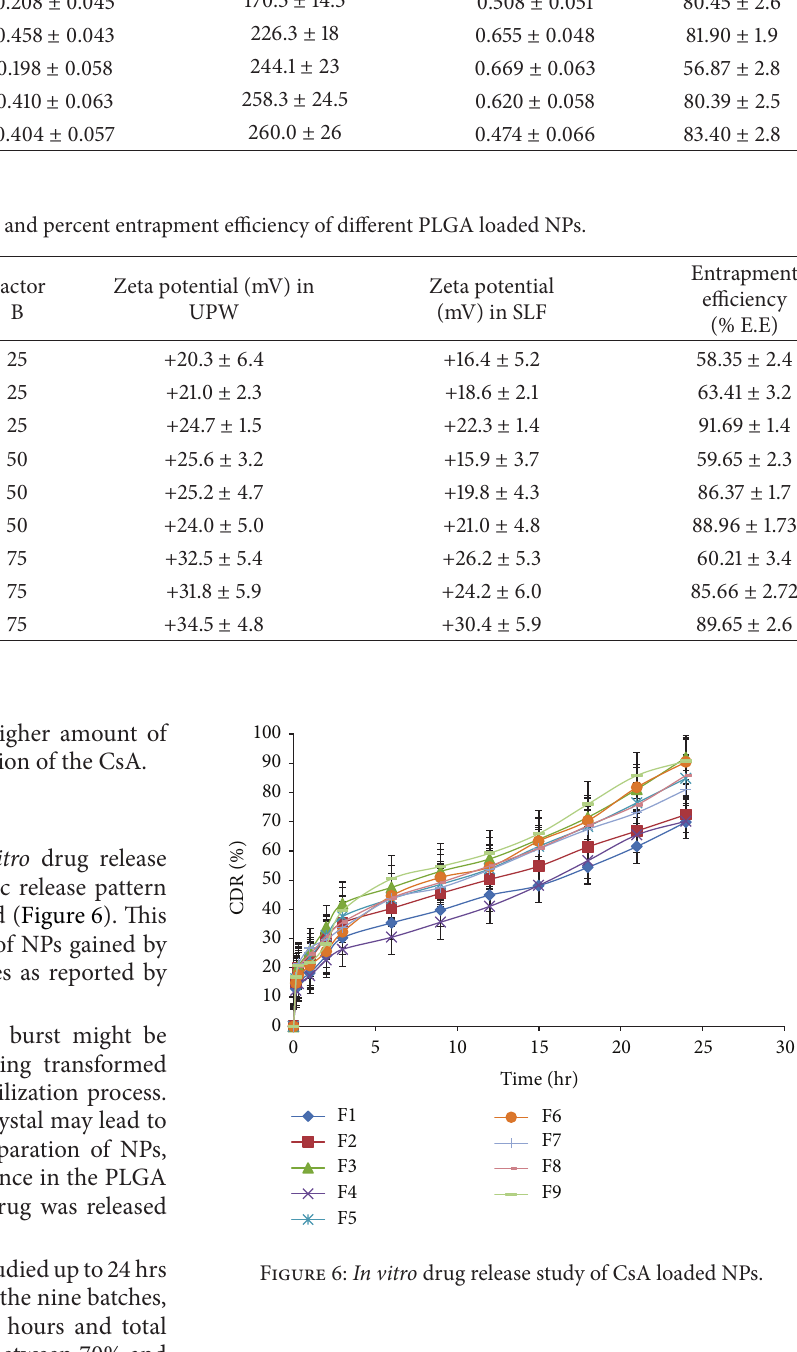
after burst release. On the other hand, the increase in PLGA concentrations prolonged the CsA release from